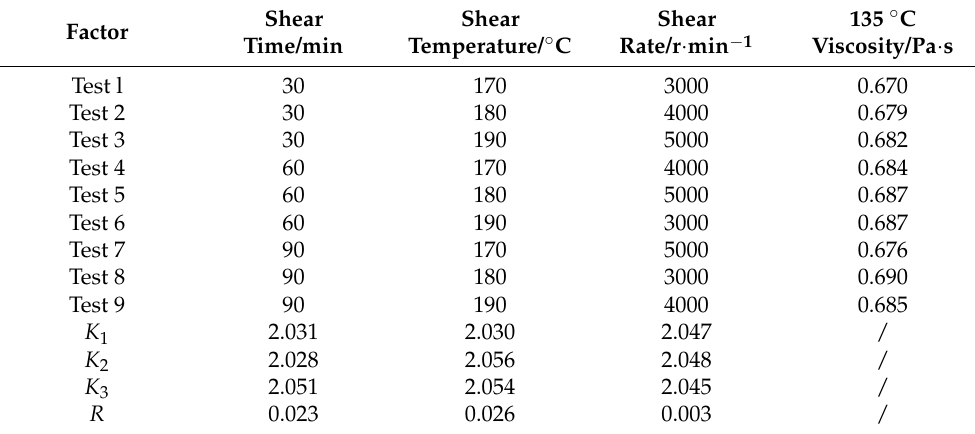
Table 12. Calculation results of viscosity test R and K values of PP-modified asphalt.